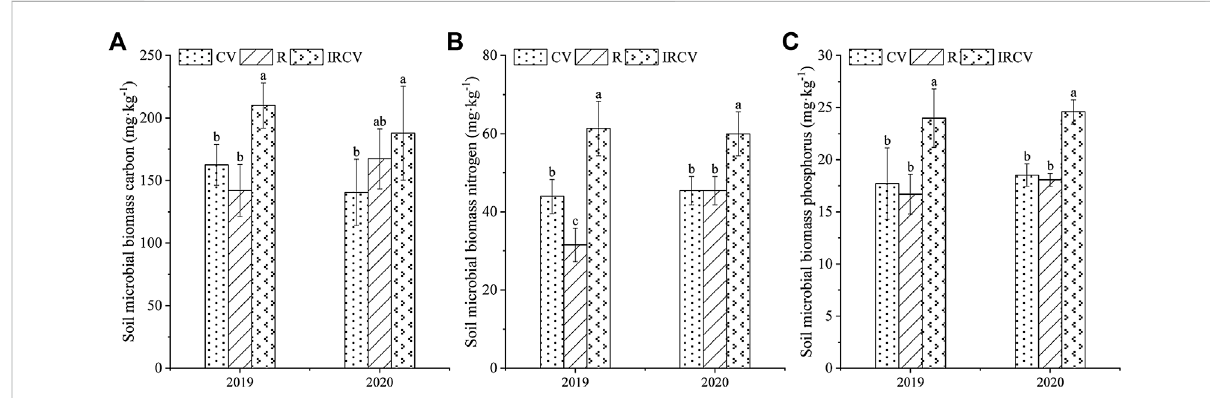
FIGURE 2 Changes in soil MBC (A) , MBN (B) , and MBP (C) under three cropping systems in 2019 – 2020. Different lowercase letters represent signi fi cant differences among treatments ( p < 0.05). CV, R, and IRCV represent the common vetch monoculture, rape monoculture, and R and CV intercropping,